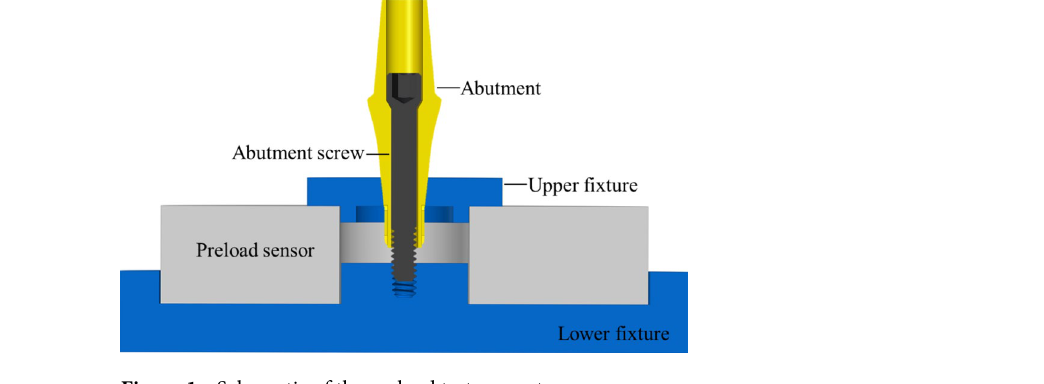
Figure 1. Schematic of the preload test